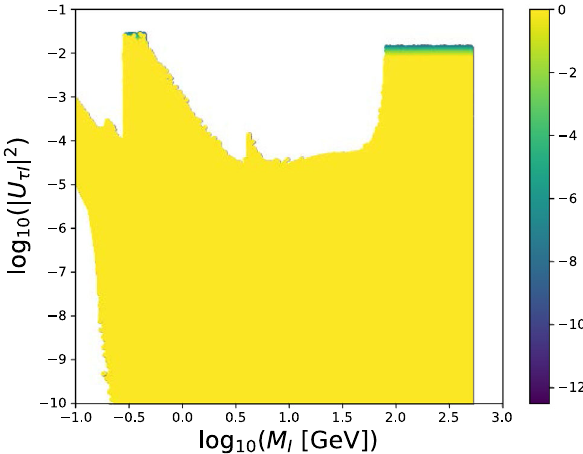
Fig. 40 Partial likelihood from the invisible decay width of the Z - boson, in the M I − | U τ I | 2 plane